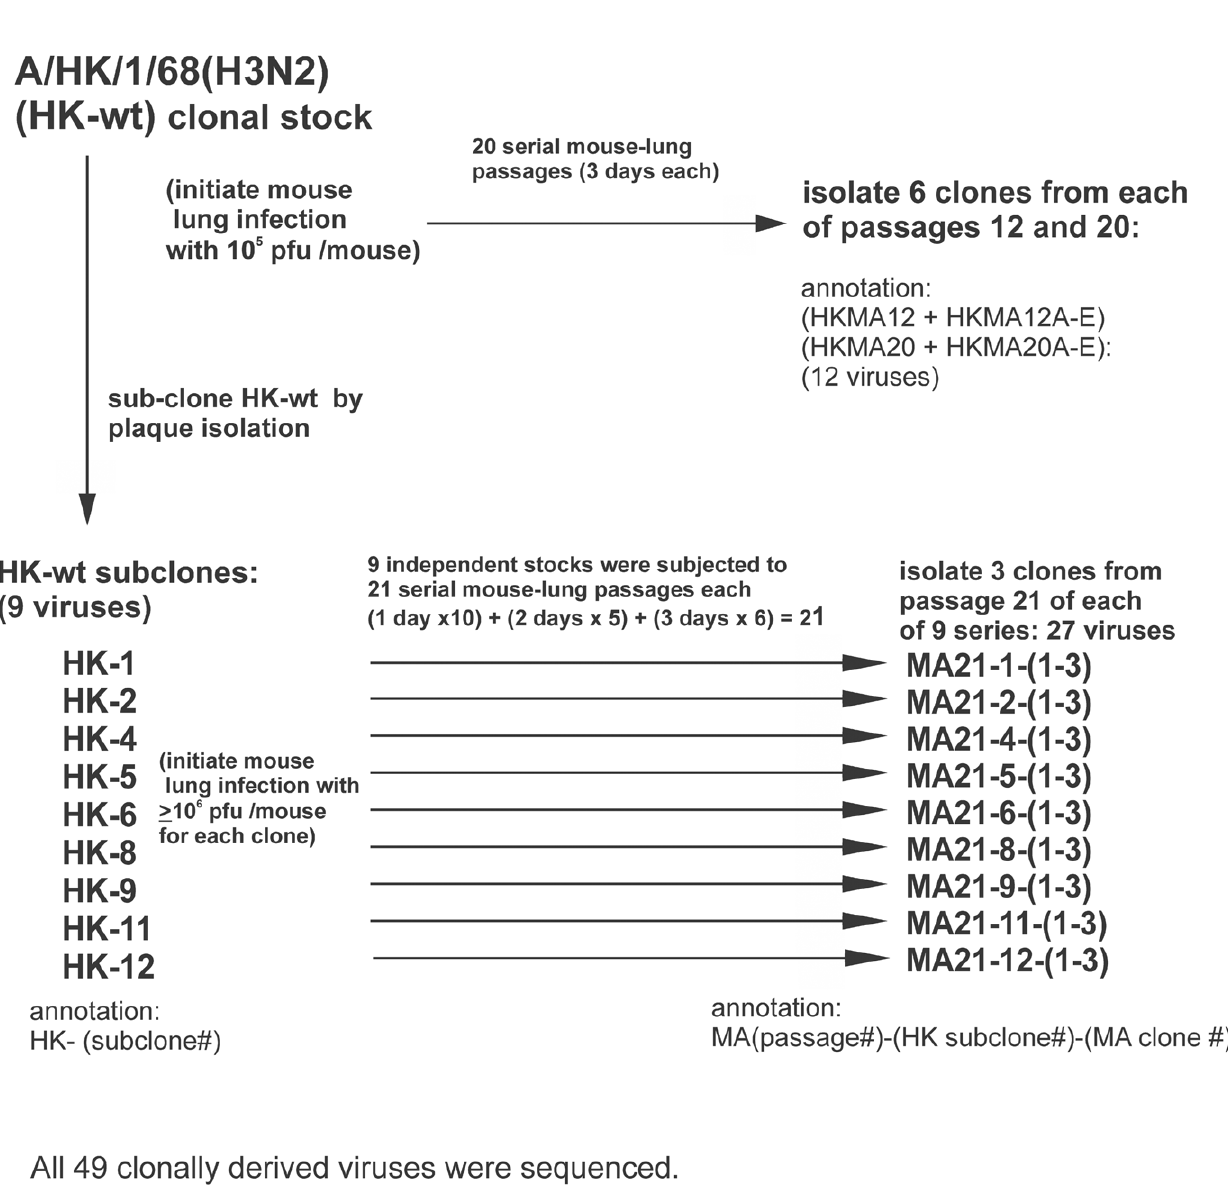
Figure 1. Experimental design of parallel studies of mouse adaptation. The parental strain of A/Hong Kong/1/68 (HK-wt) was clonally derived onMDCK cells and growninchickenembryos before dilutionin PBS to1 6 10 5 pfu/0.05 mL toinitiate serialmousepassage; followed by20serialpassages with 6 clones derived by plaque isolation from the passage 12 and 20 populations on MDCK cells. Replicate stocks of HK-wt (HK- # ) were generated from individual infectious virions of HK-wt by plaque isolation. Each subclone was amplified in eggs and used without dilution to infect mice ( $ 1 6 10 6 pfu/ 0.05 mL for each mouse) to initiate 9 parallel MA series as indicated in methods before isolating 3 clones from each of the passage 21 populations.